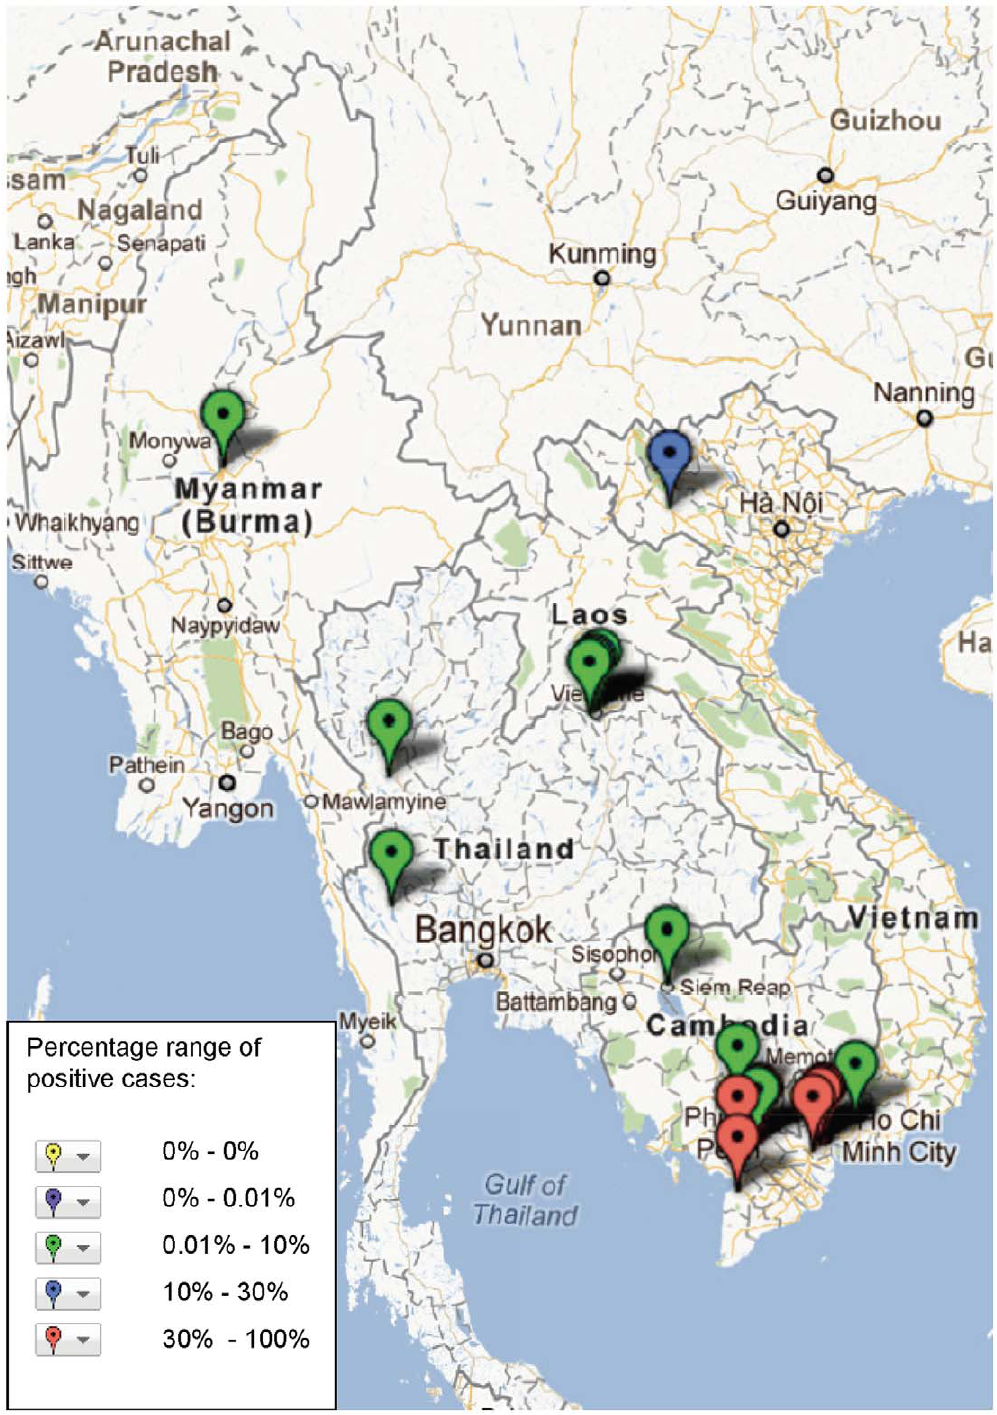
Figure 4. Study sites in the Mekong region where S. Typhi has been reported, illustrating frequency of identification (case) based on assays and sample population used in the study (see Table